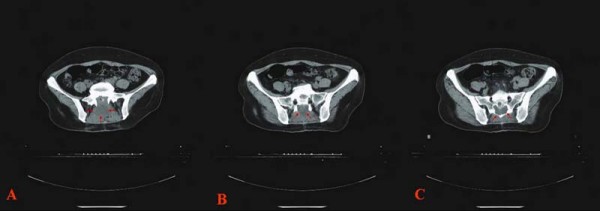
Computed tomography (CT) scan of the abdomen and plevis demonstrated a small (2 × 1.5 × 0.8 cm) low-density, well circumscribed mass in the sacrum, without evidence of tumor infitration of adjacent structures (three different CT-slice, A, B, and C).